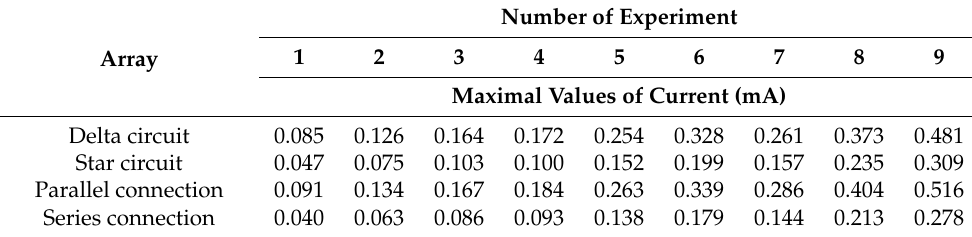
Table 6. Maximal values of generated